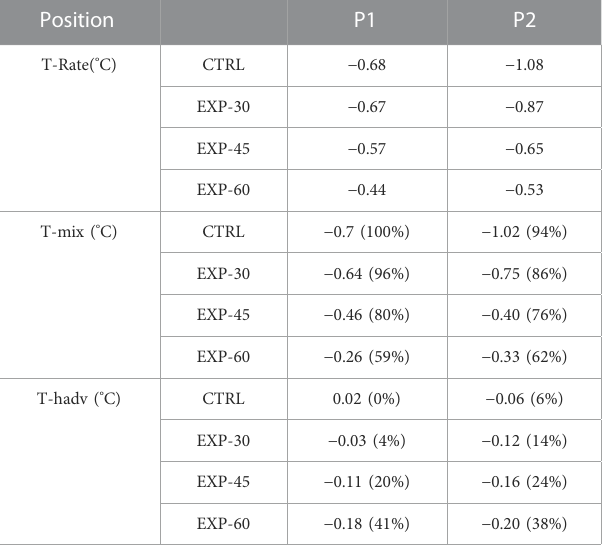
TABLE 2 The changes in SST ( ° C) and those due to the vertical mixing (T-mix) and the horizontal advection (T-hadv) at the two selected points. The periods for calculating the changes are labeled in Figure 9 with the dashed lines.